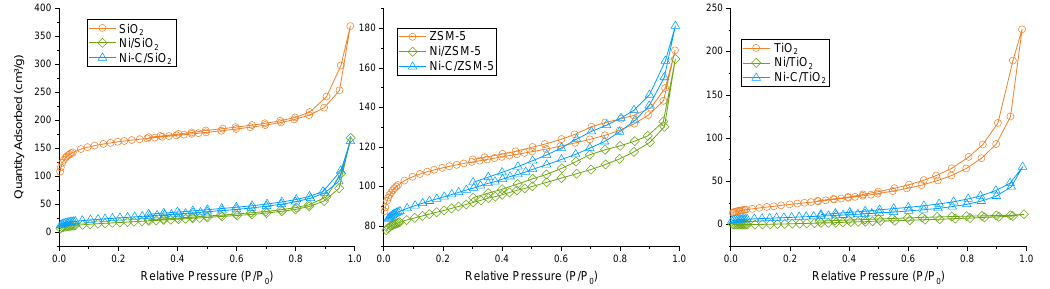
Figure 4. N 2 adsorption/desorption isotherms of examined catalysts. 182